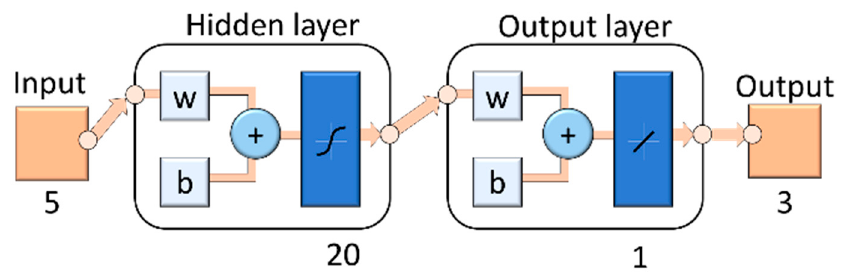
Figure 11. Architecture of the backpropagation neural network (BPNN).